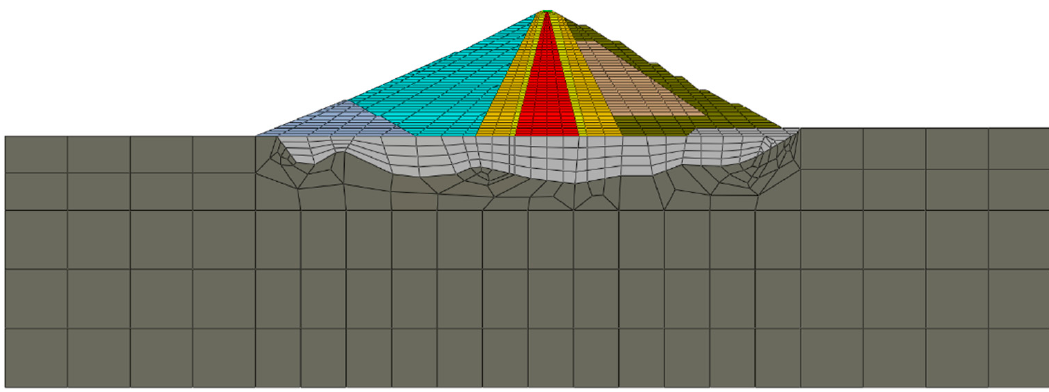
Figure 6. 2D finite element model of the dam and foundation.